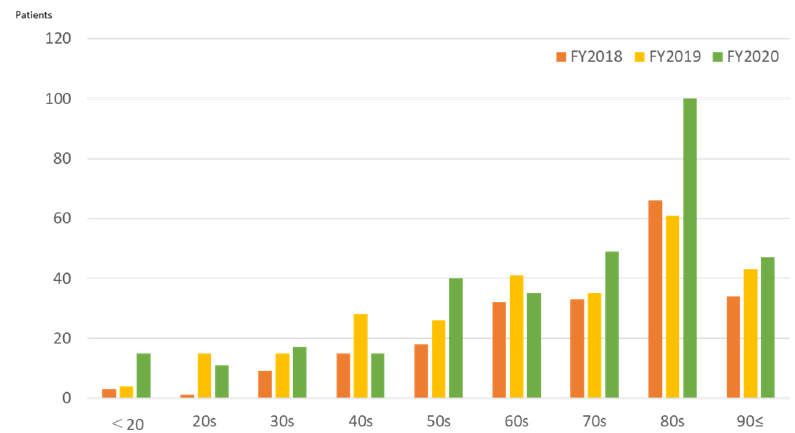
Figure 12. Number of inpatients treated at Futaba Medical Center by age cohort, FY2018–FY2020.